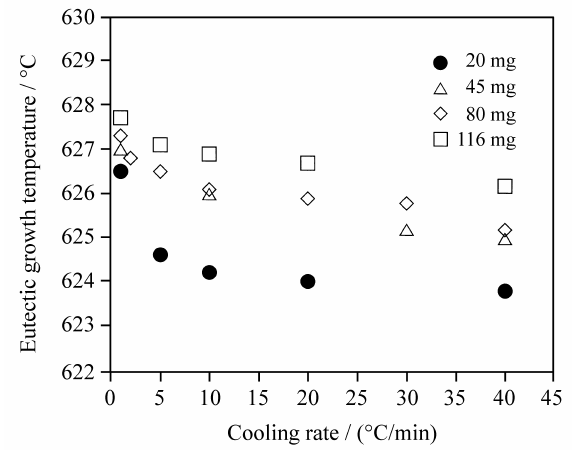
Figure 4. Lamellar spacing as a function of the inverse square root of the growth rate obtained by computing the cooling curves